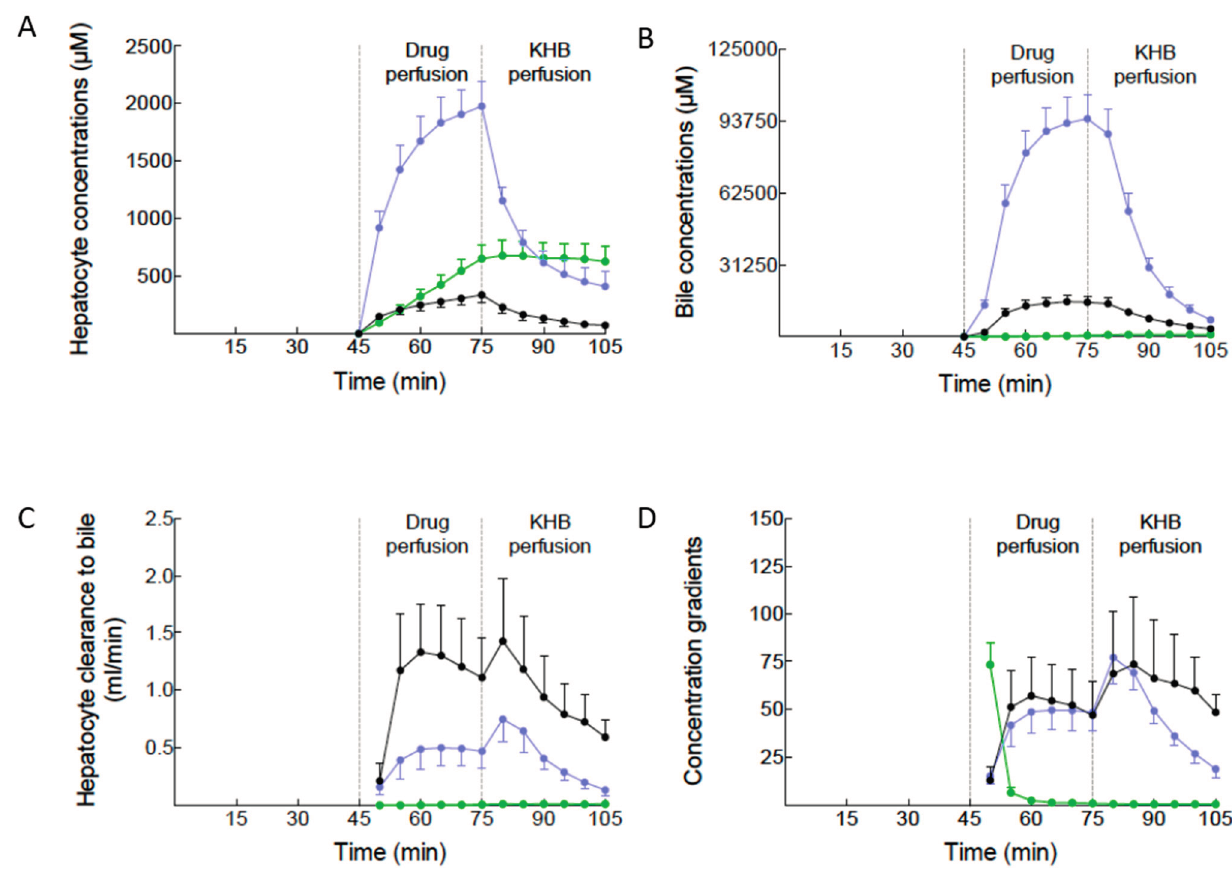
Figure 2. Drug hepatocyte concentrations ( A ); bile concentrations ( B ); hepatocyte clearance into bile ( C ); and concentration gradients between bile and hepatocytes ( D ) over time (min). The three experimental groups are described in Figure 1. During drug perfusion, constant concentrations are perfused. During KHB perfusion, no drug is perfused (rinse period). BOPTA (black circles, n = 5); BOPTA in Mrp2-deficient livers (green circles, n = 3); MEB (blue circles, n = 5). Hepatocyte concentrations were available every 20 s, but presented in the graph every 5